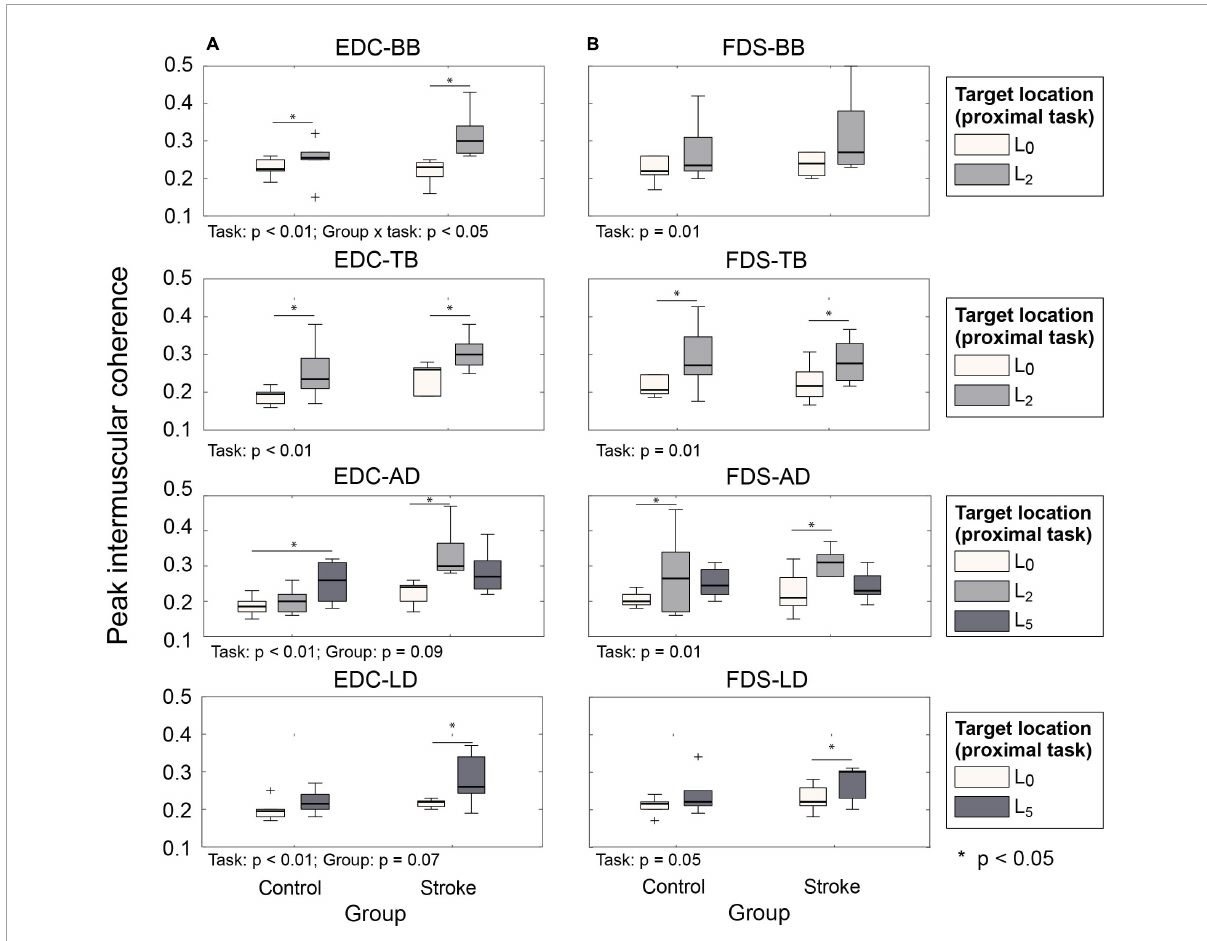
FIGURE5 Peak intermuscular coherence value during hand open phase under two proximal task conditions ( P HOr T 1 vs. P HOr T 2 ). (A) EDC and proximal muscle pairs. (B) FDS and proximal muscle pairs (EDC, extensor digitorum communis; FDS, flexor digitorum